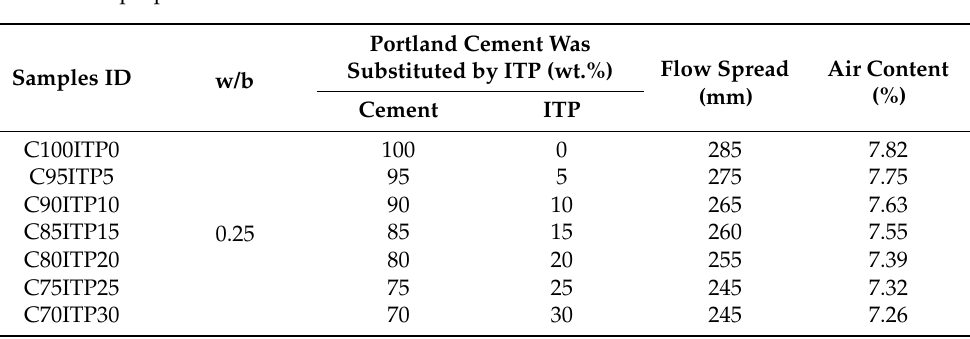
Table 4. Mix proportions for